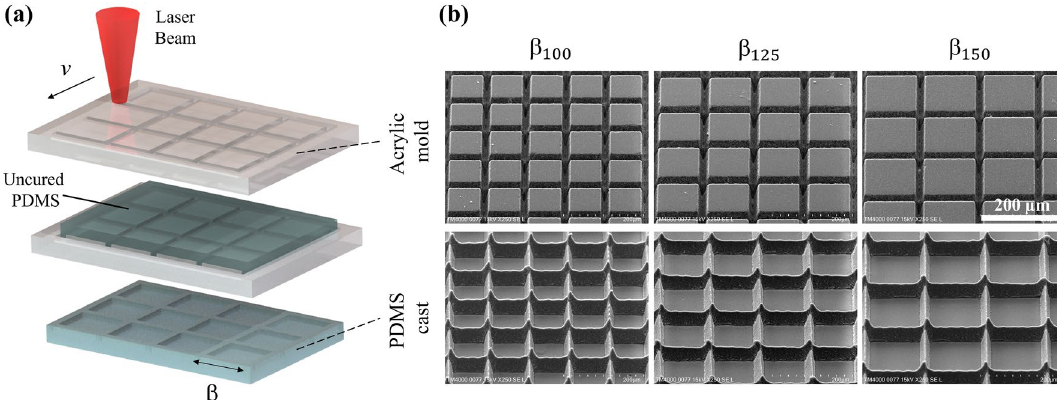
Figure 1. ( a ) Schematic of microstructure fabrication process, ( b ) SEM images at 45° tilt of negative acrylic molds (top row) and cured PDMS casted microstructures (bottom row). Scale bar (200 µm) is uniform across